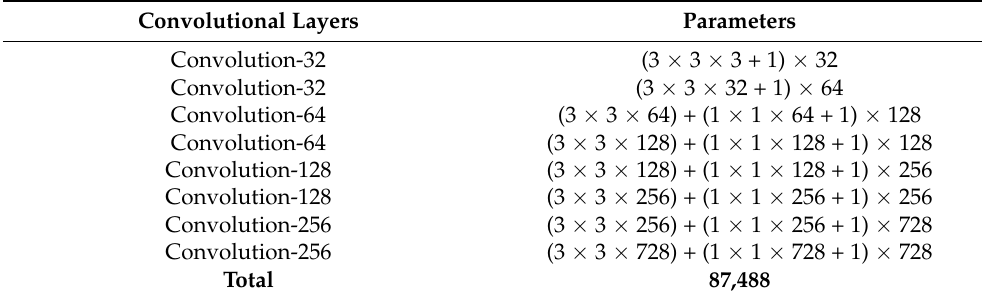
Table 3. Parametric configuration of the convolutional layer of proposed